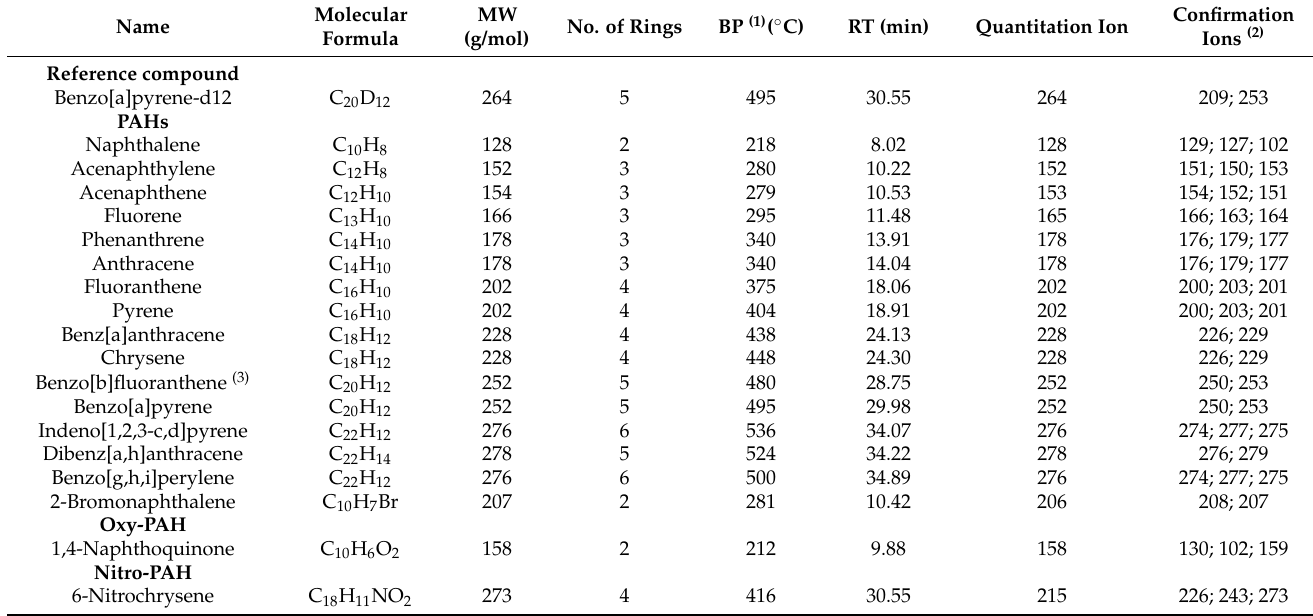
Table 5. Physical and chemical properties of the studied PAHs and PAH derivatives with their retention time, and ions used for quantitative GC-MS